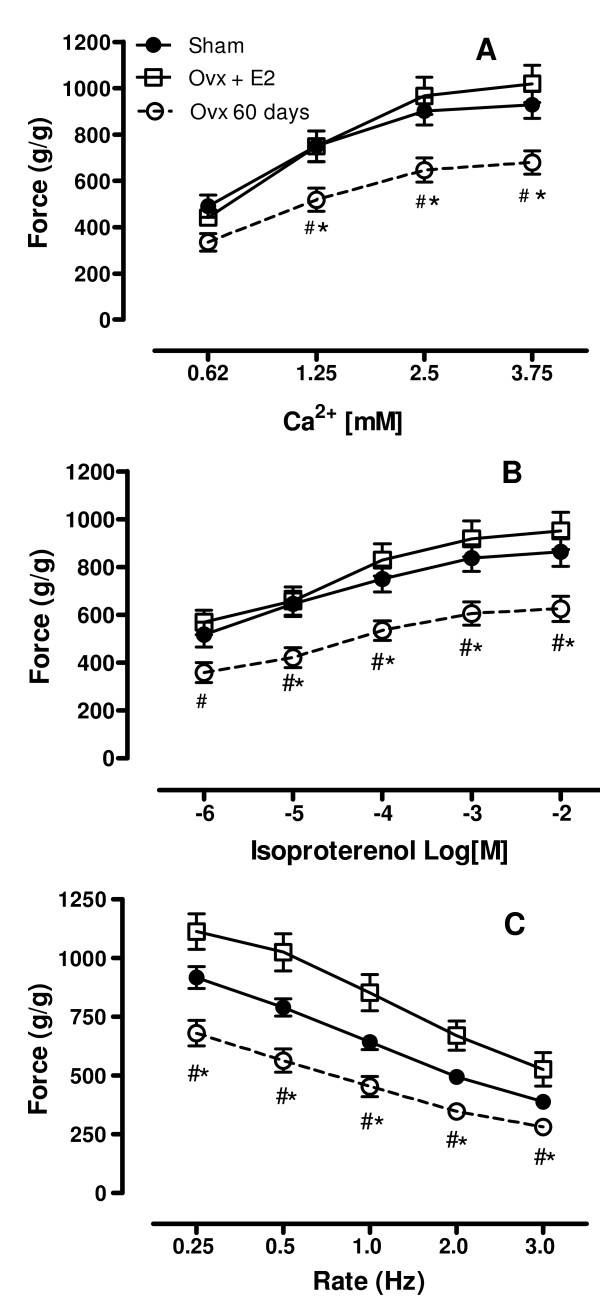
Estrogen effects on inotropic stimulus. Effect of estrogen replacement therapy with estradiol valerate on myocardial contractility 60 days after ovariectomy. Estrogen restores inotropic response to extracellular calcium (A) and isoproterenol (B) as well as the rate-isometric force development relationship (C). Force (g/g) values are expressed as mean ± S.E.M. * Ovx n = 8 vs. Sham n = 22, # Ovx vs. Ovx + E2 n = 8, different (P < 0.05) using two-way ANOVA and post hoc Tukey test.